Question: Which kind of chart has been used to present this data?
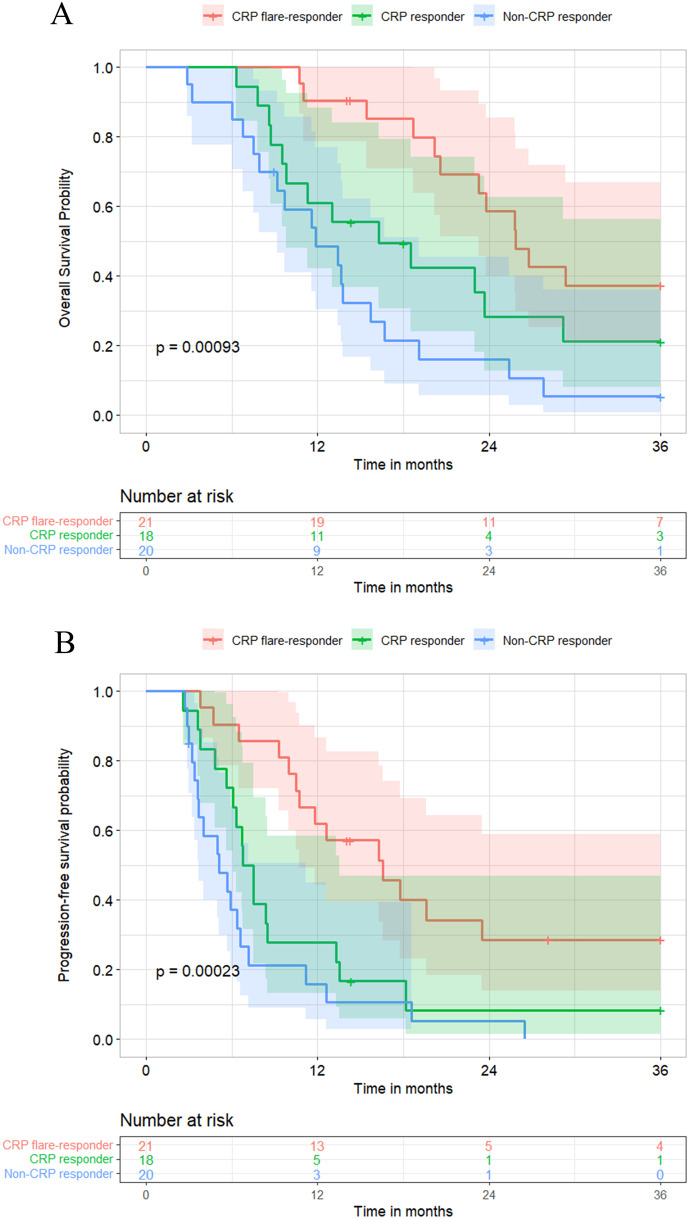
Answer: survival